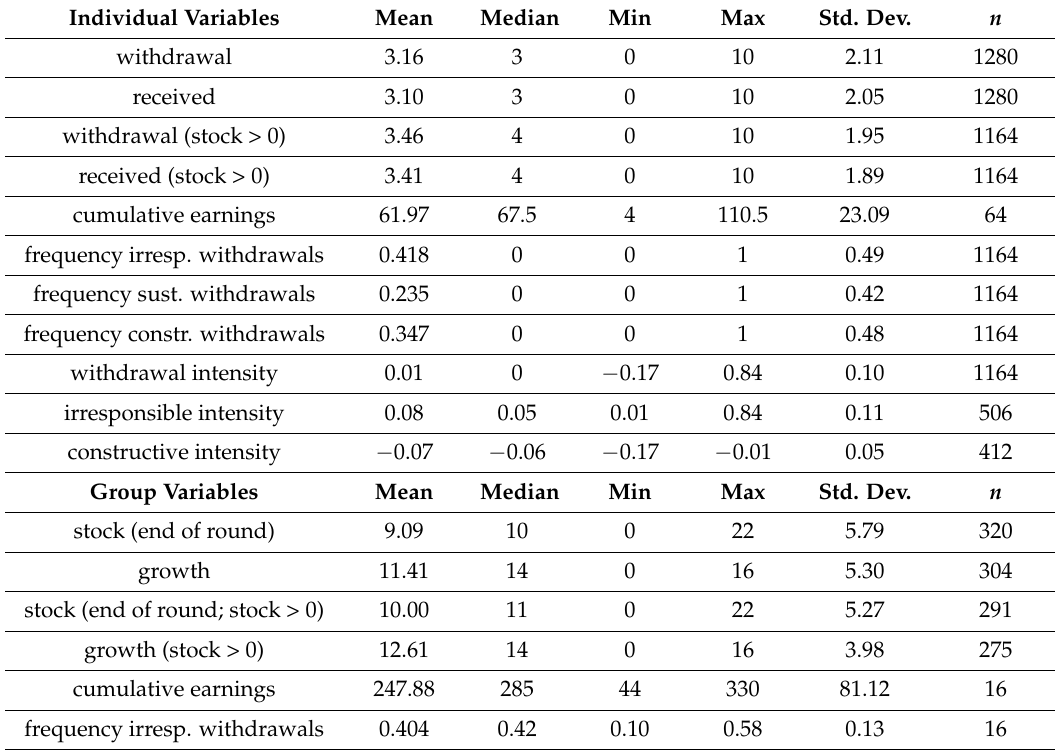
Table 1. Summary